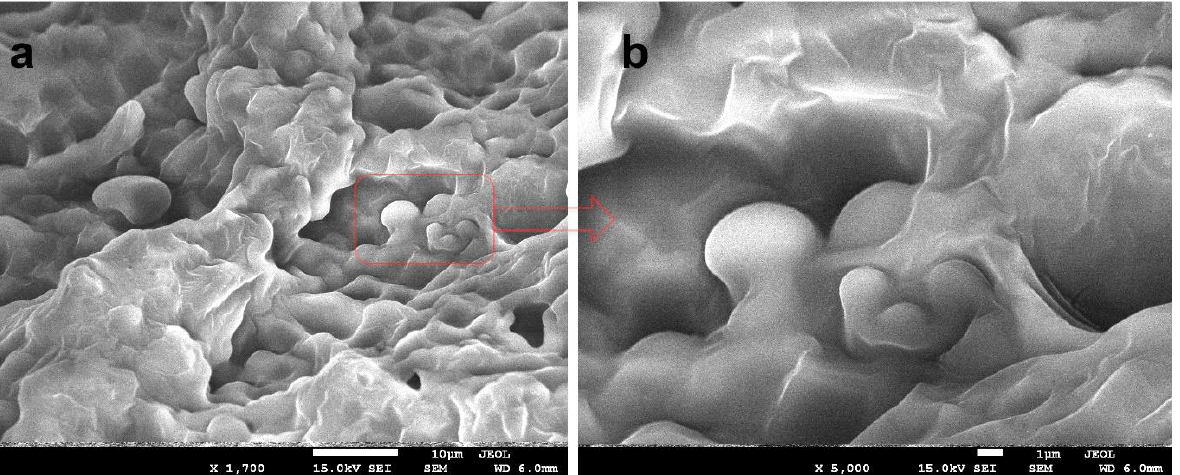
Figure 6. A SEM image of the Cur-2 composite on the surface ( a ) and in cross-section ( b ).